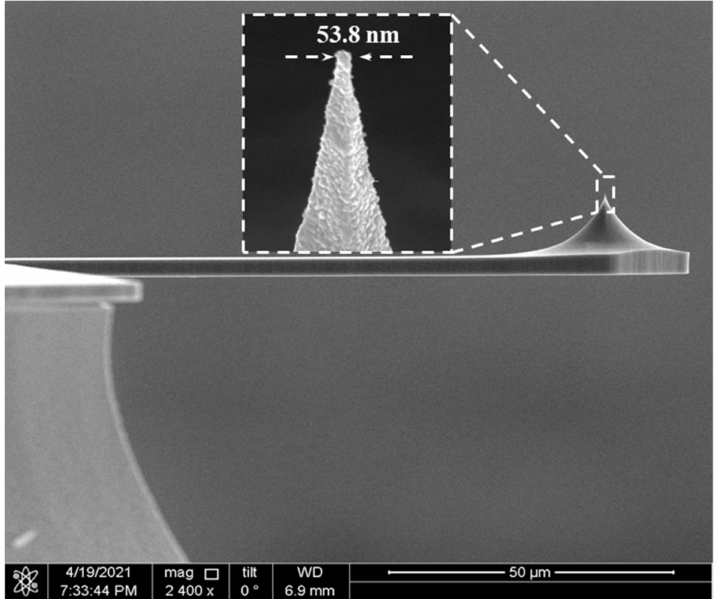
Figure 8. SEM image of the conductive probe.